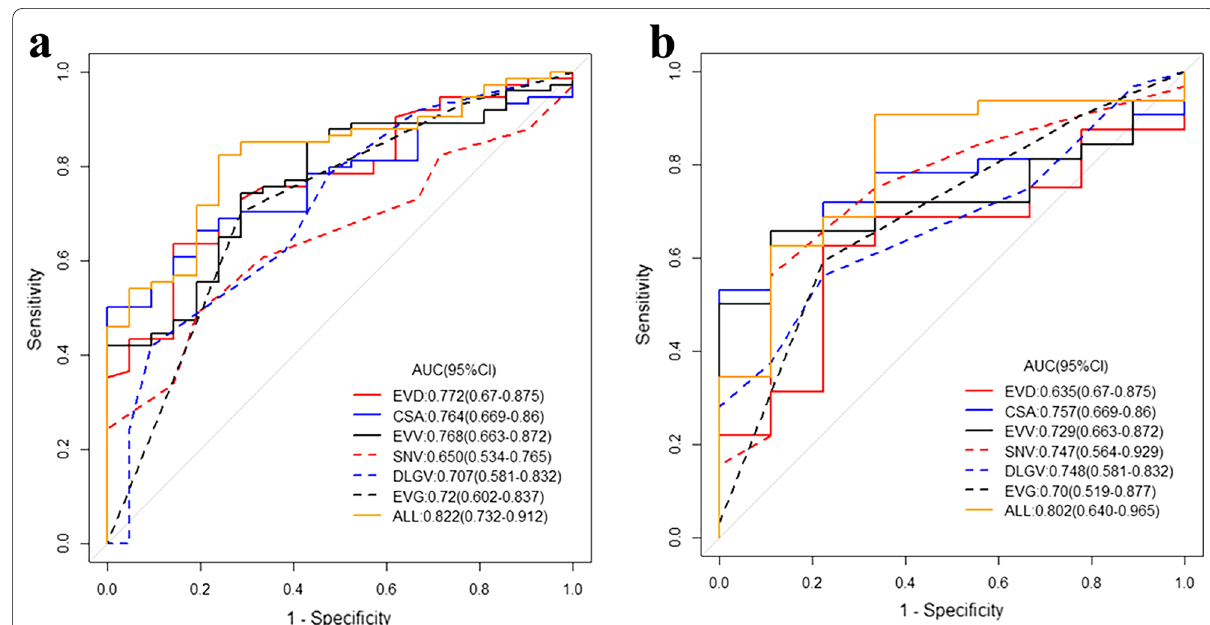
Fig. 4 Receiver operating characteristic (ROC) analysis of each index for predicting severe EV in the training ( a ) and validation cohort ( b ), the area under the curves (AUC) and 95% confidence interval (CI) are also displayed